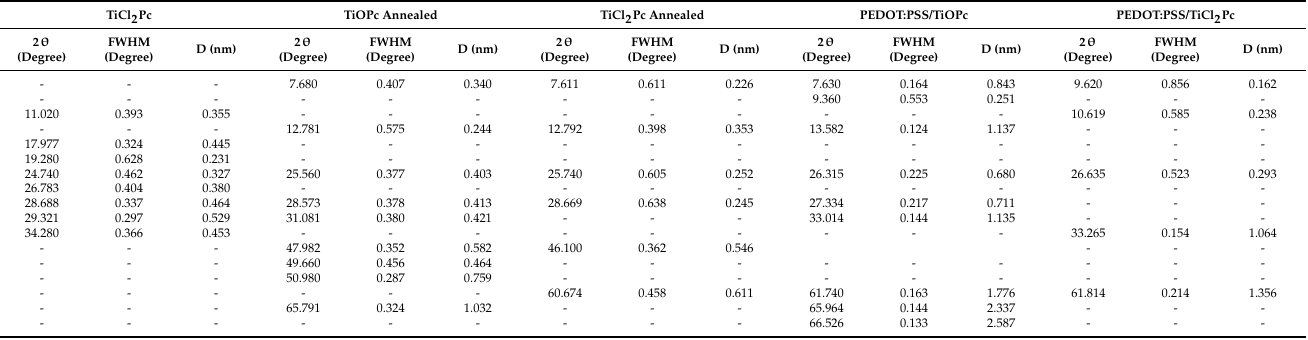
Table 3. XRD peak position, FWHM, and crystallite size for the TiOPc and TiCl 2 Pc films and